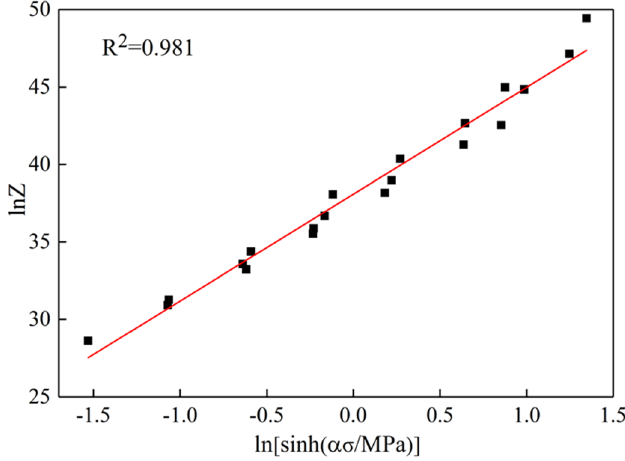
Figure 4. Linear fitting relationship between ln [ sinh ( ασ )] and lnZ .